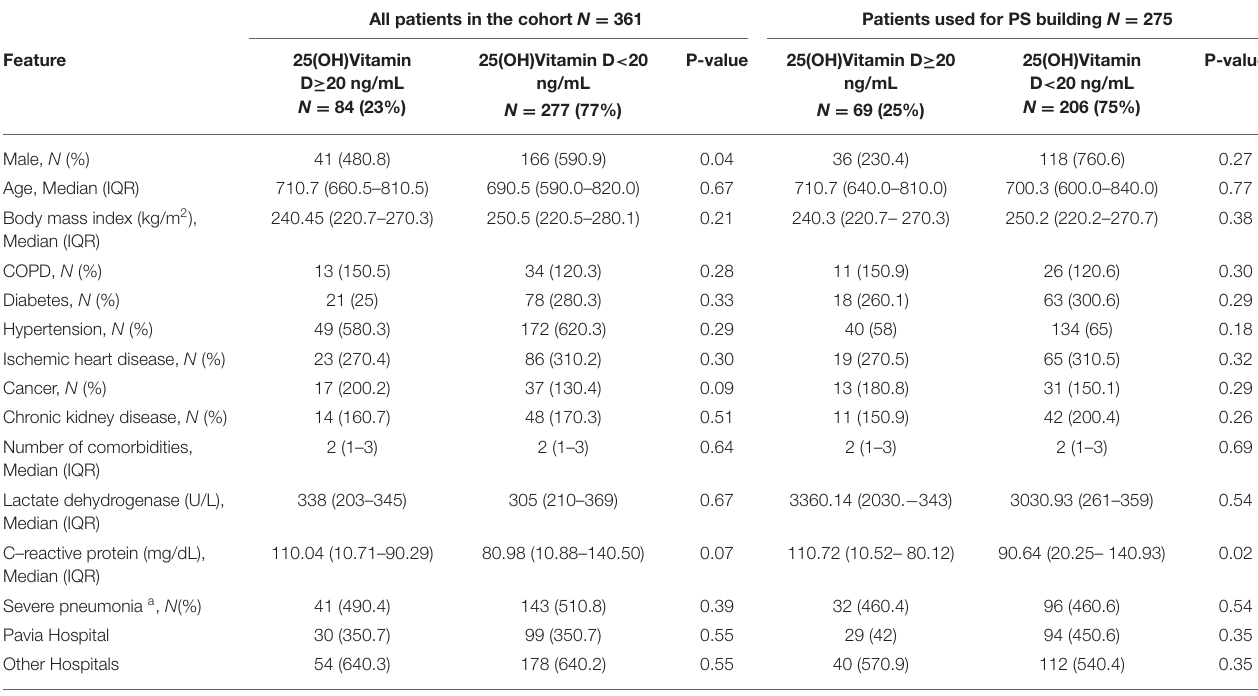
TABLE 1 | Clinical and demographic characteristics of the enrolled patients. All patients in the cohort N = 361 Patients used for PS building N =